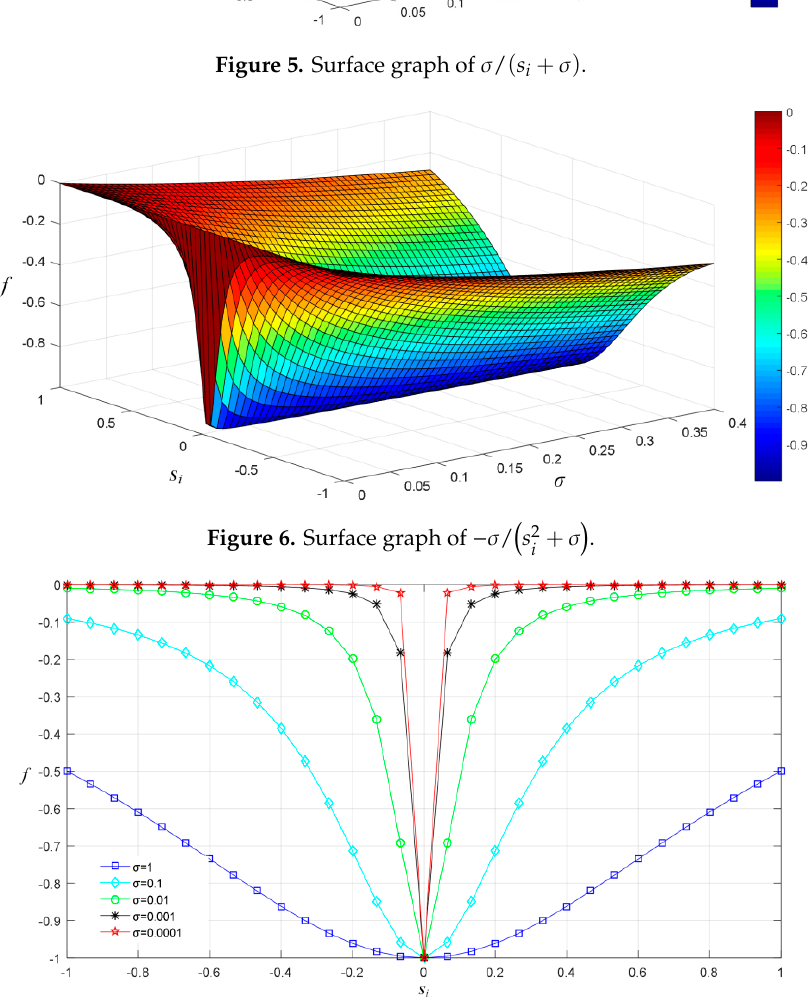
(cid:16) (cid:17) − σ / + σ s 2 with di ff erent σ i